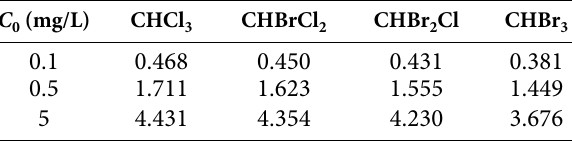
Table 4. The maximum adsorption capacity of SMMT (mg/g) for CHCl 3 , CHBrCl 2 , CHBr 2 Cl, and CHBr 3 at different initial concen- trations of THMs ( C 0 ) . C 0 (mg/L) CHCl 3 CHBrCl 2